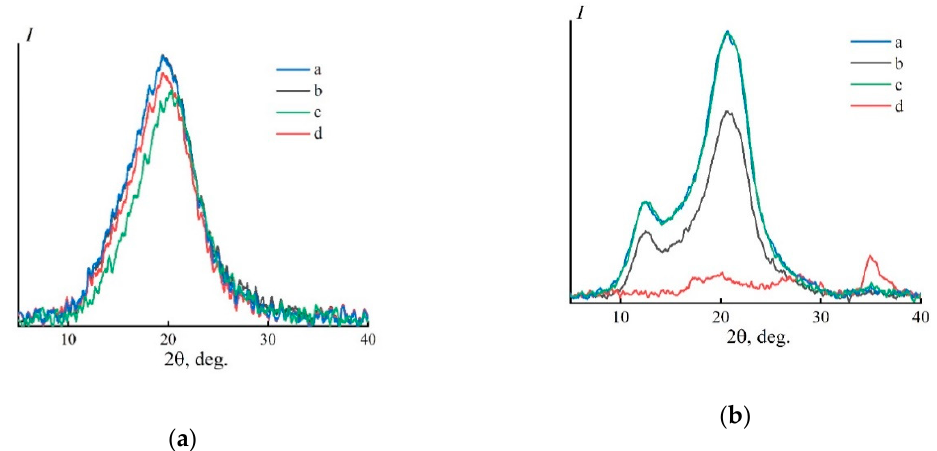
Figure 5. Equatorial (a,c) and meridional (b,d) diffraction patterns for cellulose fibers obtained through isobutanol baths (25 °C) and dried under room conditions ( a ) and equatorial (a,c) and meridional (b,d) diffraction patterns for cellulose fibers obtained through isobutanol baths (25 °C), washed in water, and dried ( b ). Geometry of scanning—“reflection” (a,b) and “transmission” (c,d).